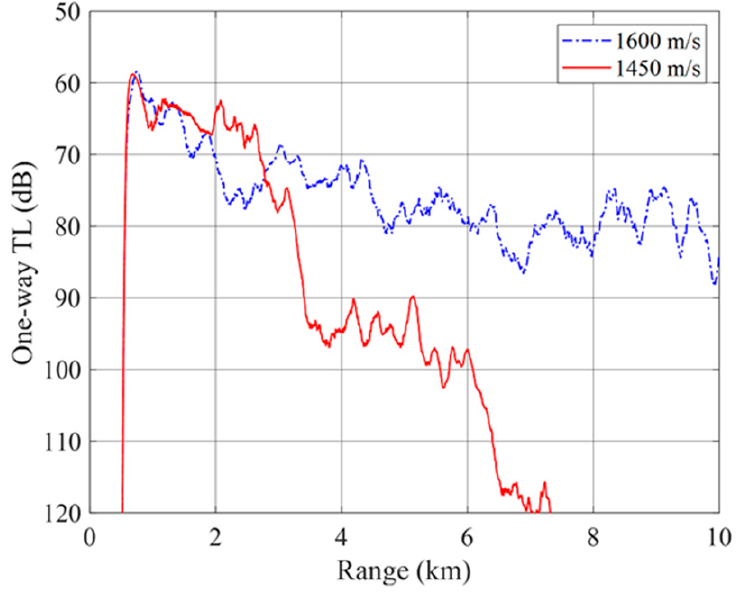
Figure 7. Range-averaged one-way transmission losses between source and bottom cells for soft bottom (1450 m/s) and hard bottom (1600 m/s).